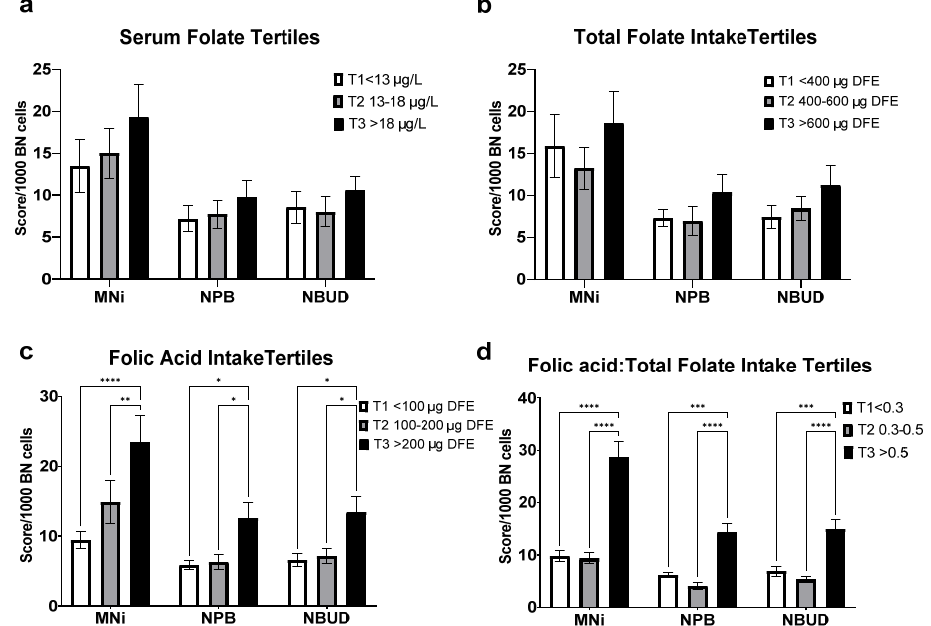
Figure 3. Frequency of Cytome biomarkers in human lymphocytes relative to: ( a ) serum folate tertiles 1. ( b ) Total dietary folate intake tertiles. ( c ) Dietary folic acid intake tertiles. ( d ) Folic acid intake: